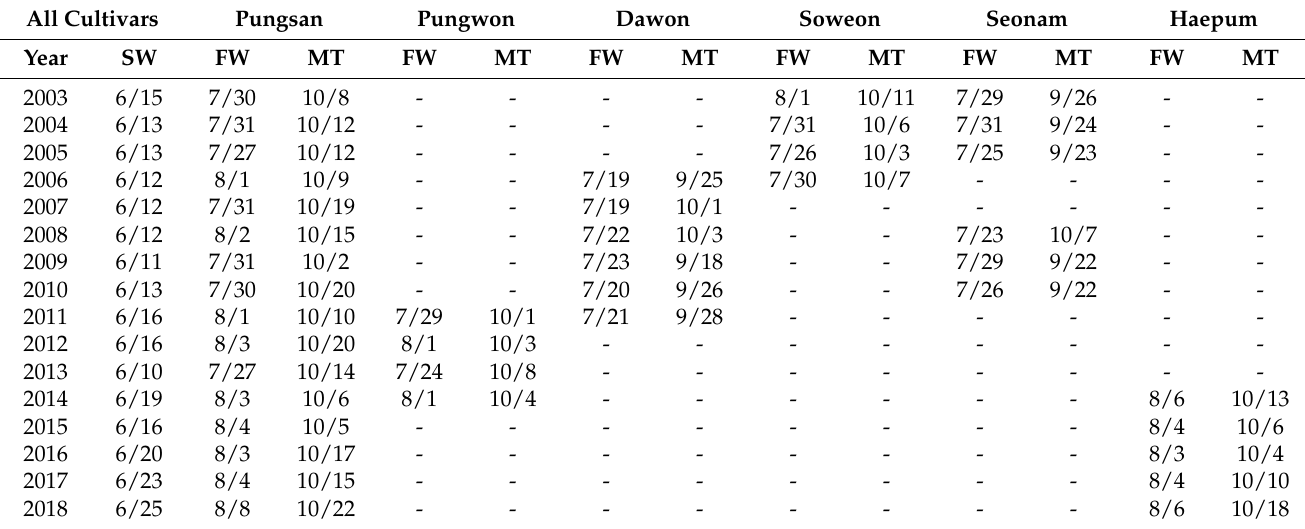
Table 2. Dates of sowing, flowering, and maturity for all six soybean sprout cultivars used in this study during 2003–2018 (– indicates no data available). SW indicates sowing date; FW indicates flowering date; and MT indicates maturity date. All